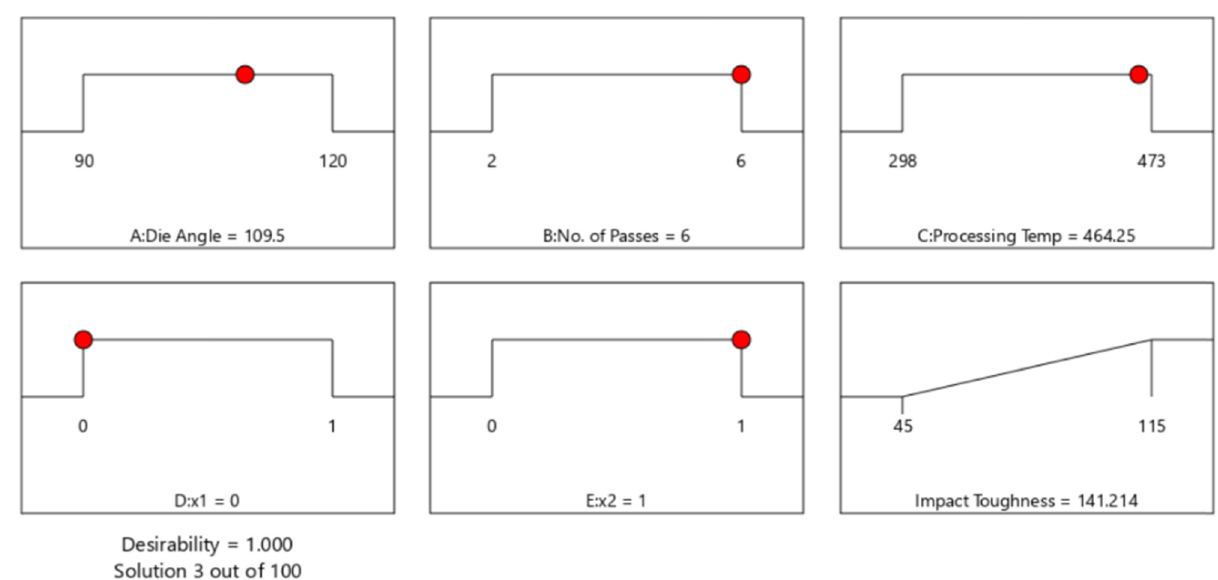
Figure 22: RSM optimization results of I T